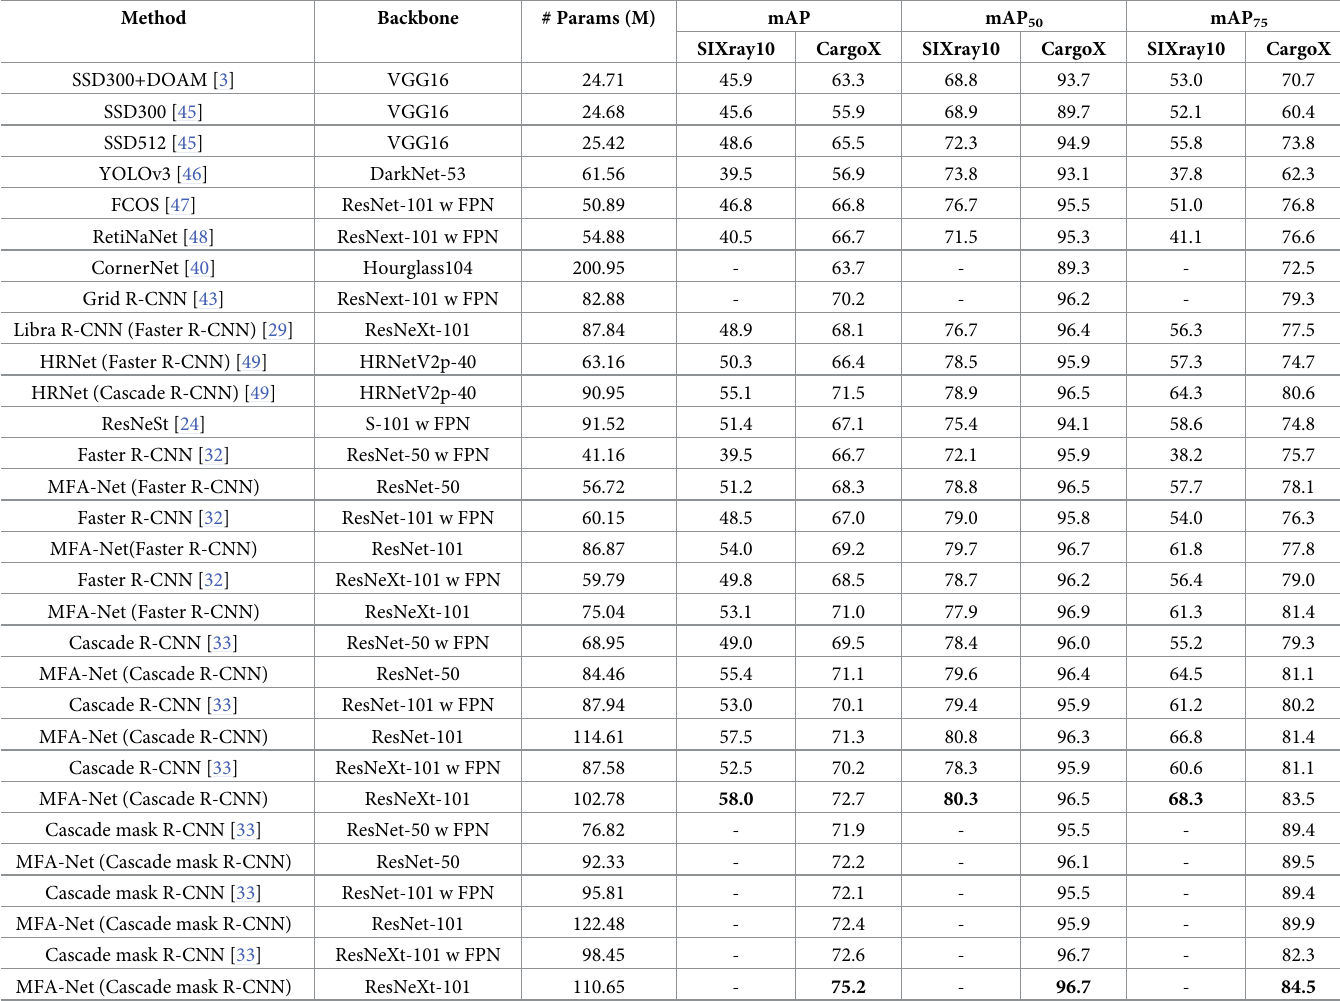
Table 7. Performance comparison with state-of-the-art algorithms on the SIXray and CargoX datasets.